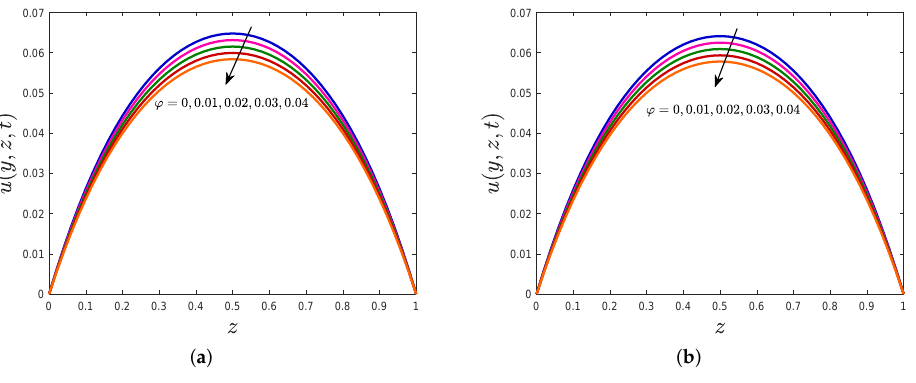
Figure 10. One-dimensional velocity profile for various values of ϕ . ( a ) Maxwell fluid, ( b ) Newtonian